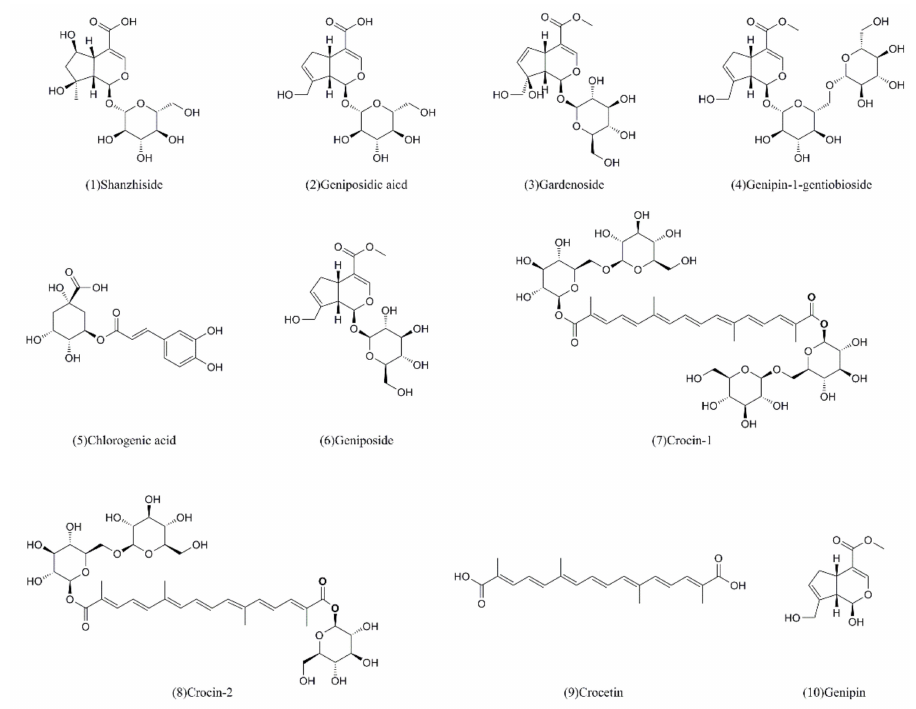
Figure 3. The ten compounds from Fructus Gardeniae screened for hepatotoxicity. Table 3. Compounds of Fructus Gardeniae extract on the cell viability of BRL-3A cells (%). Samples 10 µ g / mL 50 µ g / mL 100 µ g / mL 150 µ g /